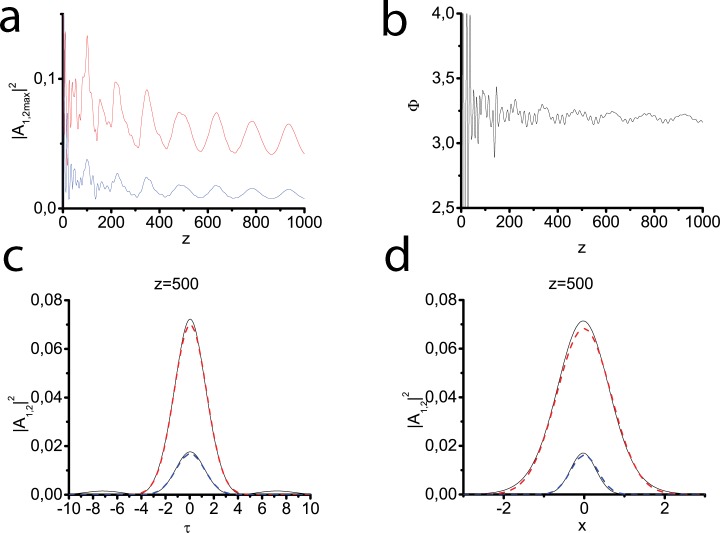
The same as in Fig 4 but waveguide has a tangential profile (2.5).